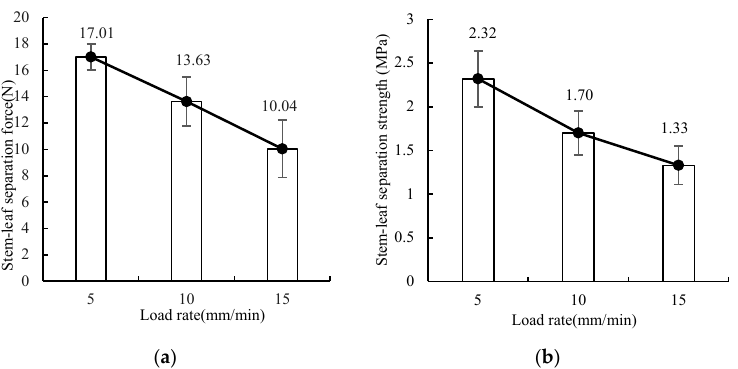
Figure 22. Wakame stem–leaf separation force and strength under different loading rates. ( a ) wakame stem–leaf separation force under different loading rates; ( b ) wakame stem–leaf separation strength under different loading rates.